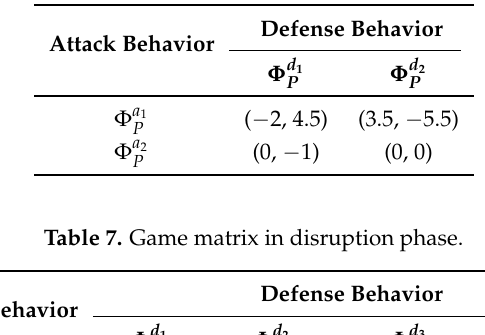
Table 6. Game matrix in penetration phase.